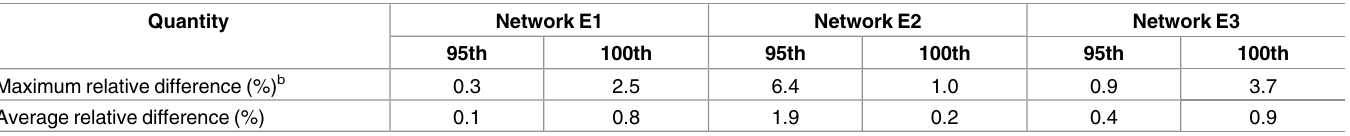
Average relative difference (%) a For seven dose levels (from 10 -4 to 100 mg, by decade). Impacts were obtained using a non-probabilistic model for ingestion that assumes individualsdrink the same amount of tap water at five fixed times during the day. Results are for an ensemble, with a 168-h simulation and contaminant injected during the first hour. b Relative difference in impacts equals the absolute value of the difference between the impacts obtained for a particular dose level using 1-s and 60-s water- quality time steps divided by the impact obtained using a 60-s time